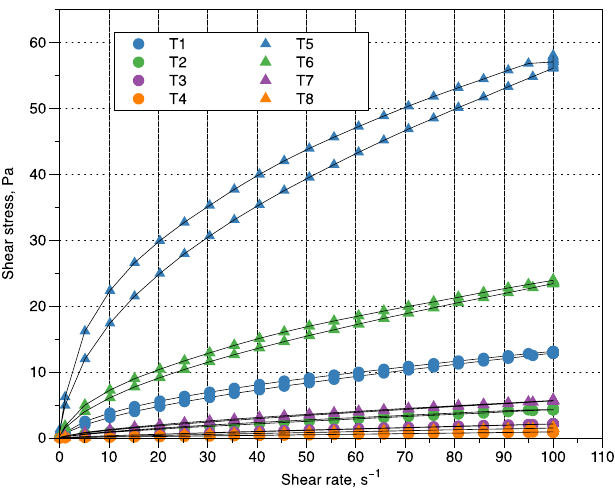
Figure 1. Flow behavior of vanilla flavored ice cream mixes (Concentration CS 04%, T1 (20:80